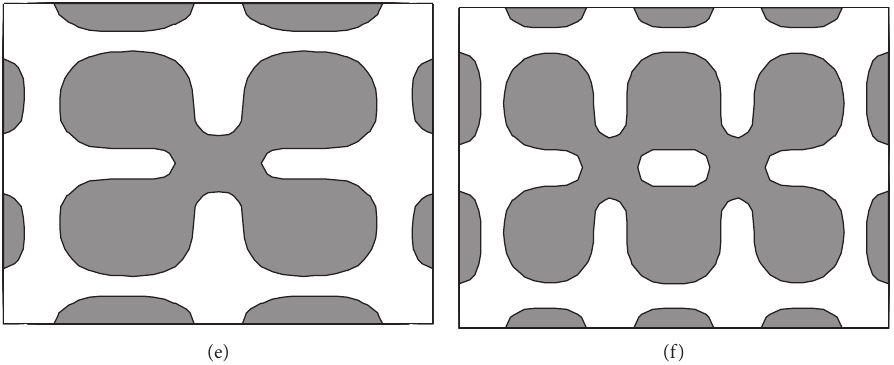
Figure 15: Optimized results for the first 6 modals: (a) 1st modal, (b) 2nd modal, (c) 3rd modal, (d) 4th modal, (e) 5th modal, and (f) 6th modal.